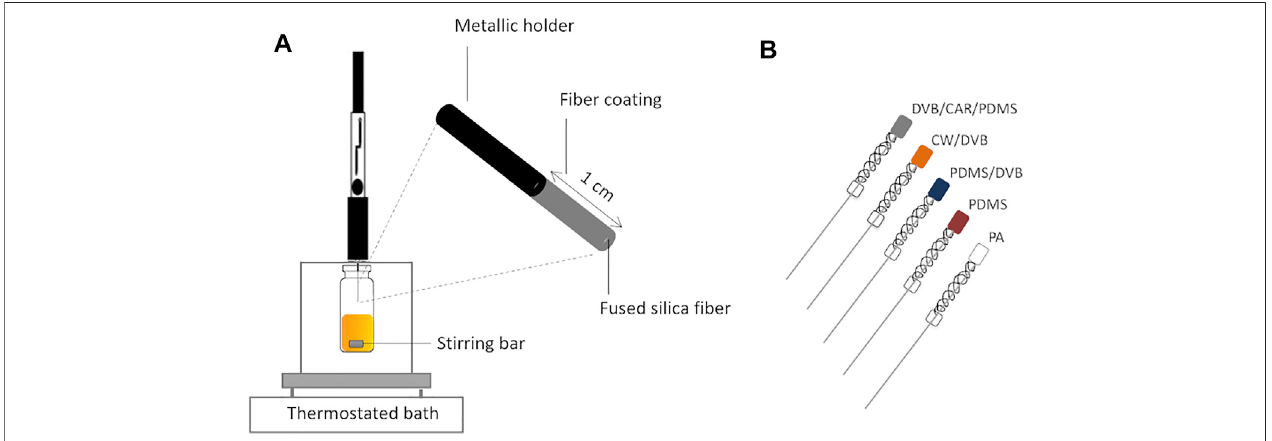
FIGURE 4 | Schematic representation of (A) solid-phase microextraction in the headspace mode (HS-SPME) using manual syringe extraction holder and the (B) most used commercial stationary phases: DVB/CAR/PDMS — 50/30 µm divinylbenzene/carboxen/polydimethylsiloxane; CW/DVB — 65 µm carbowax/divinylbenzene; PDMS/DVB — 65 µm polydimethylsiloxane/divinylbenzene; PDMS — 100 µm polydimethylsiloxane; PA — 85 µm